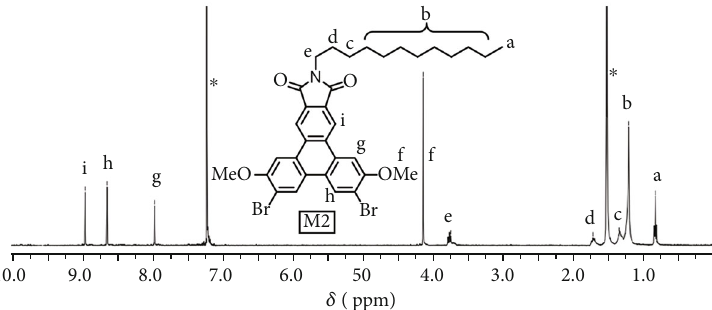
Figure 1: 1 H NMR spectrum of monomer M2 in CDCl